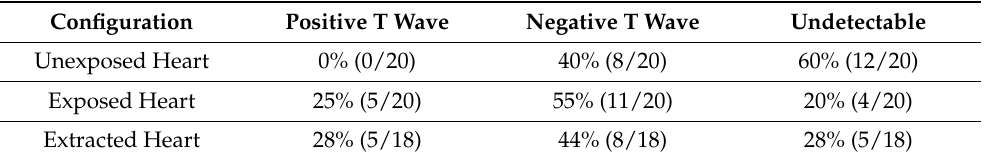
Table 2. Characteristics of the T waves in the different configurations. Data are presented as percentages (proportion of animals indicated in